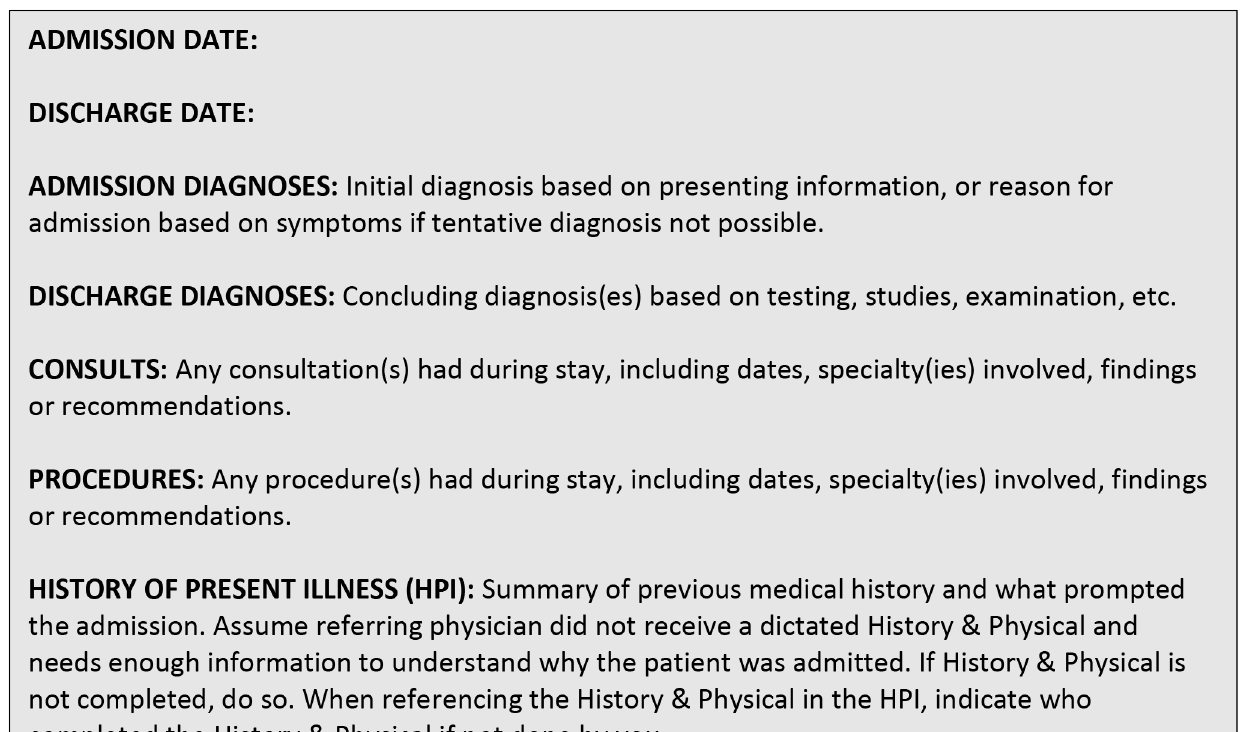
Figure 1: Template for Discharge